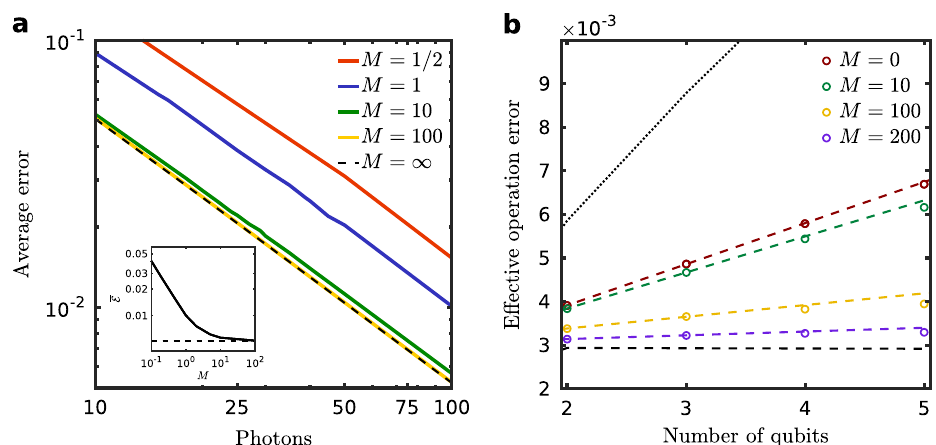
Fig. 4 a Average error E of X π gates generated by an itinerant drive pulse which initially had an average photon number n and has reached ffiffiffi p Þ per cycle as indicated, j i ¼ ð g j i þ i e j iÞ = 2 the steady state due to ancilla refreshing. The drive is set to interact with M ideal ancillas ð χ A A A leading to effective refreshing of the drive state. The dashed line indicates the lower bound of error which is achieved either with a disposable optimal pulse or with a pulse refreshed by in fi nitely many ideal ancillas. The inset shows the average gate error as a function of M for n ¼ 100 . = E b State preparation error per qubit E ffiffiffiffiffiffiffiffi p eff GHZ / N for a register of N qubits initially in a GHZ state. The target gate is an X π /2 rotation for all qubits π = 2 individually, implemented by a squeezed state of n ¼ 100 photons ( r ¼ ln ) that is refreshed by M ideal ancillas per cycle. The circles represent the data, whereas the colored lines extend the line segments between the fi rst two data points, to distinguish deviations from linear behavior. The black dashed line represents the error obtained using N disposable pulses of constant photon number n ¼ 100 . The dotted line is the error due to disposable pulses of constant total energy n ¼ 100 = N